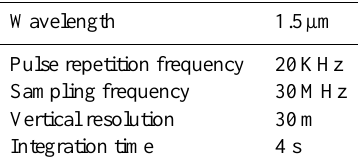
Table 2. Technical specifications of Doppler lidar.